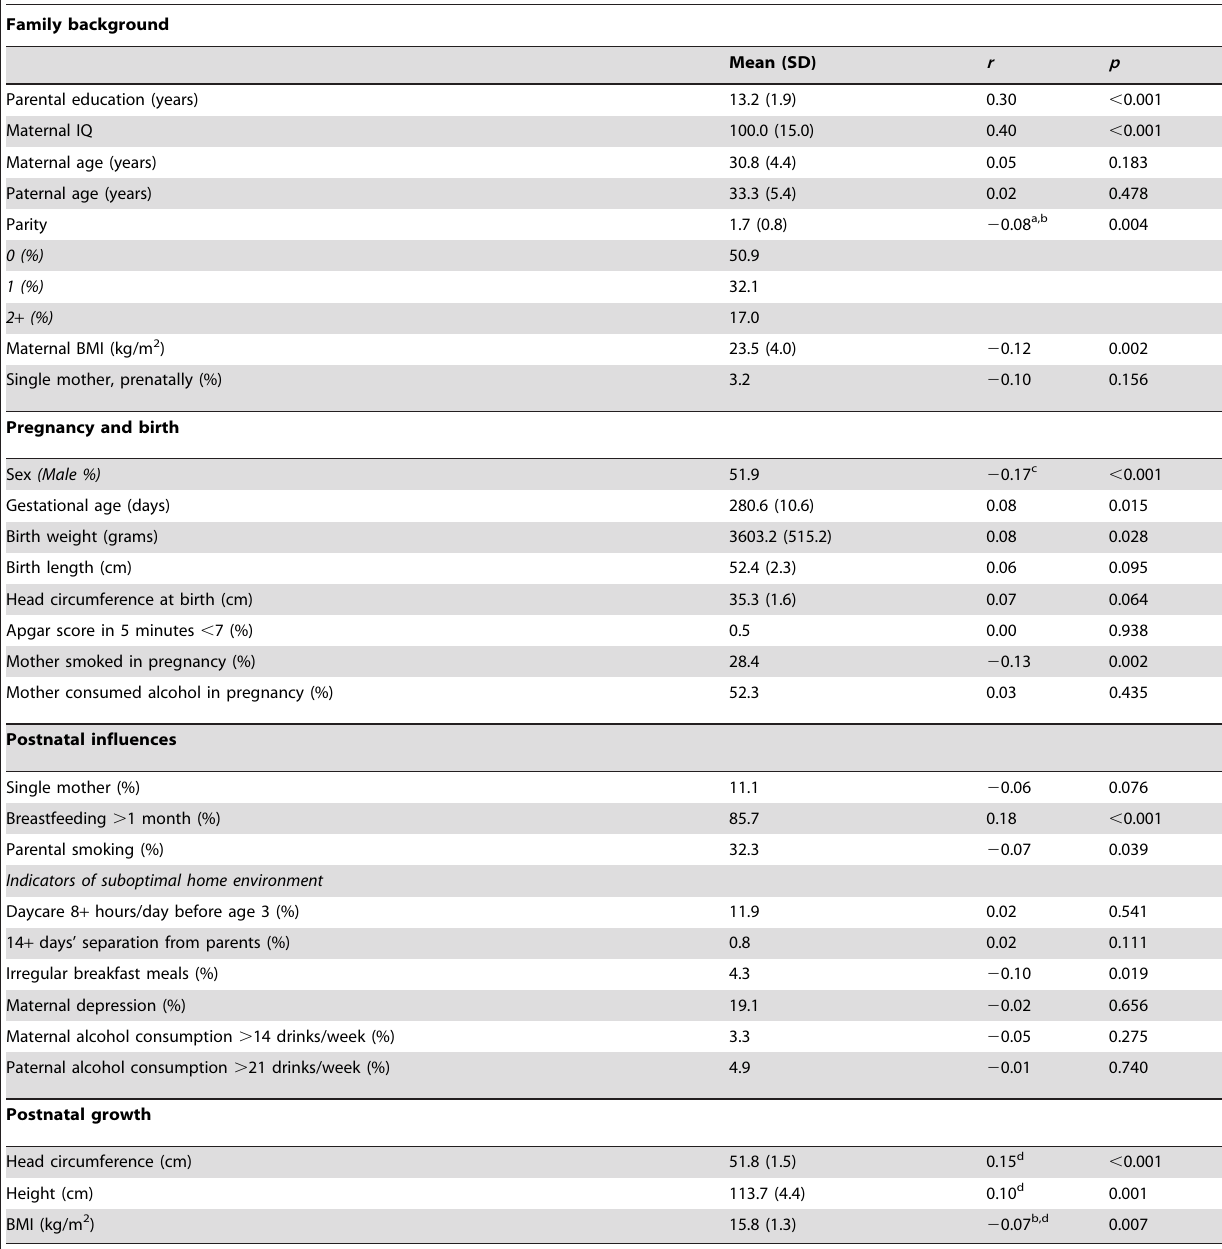
Table 1. Study sample characteristics, Denmark